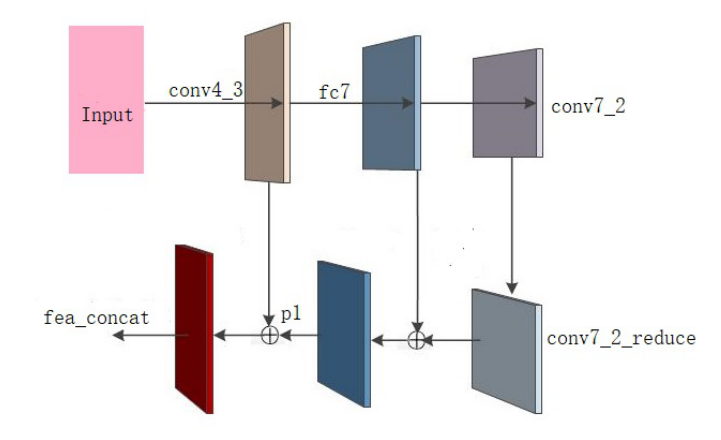
Figure 5. Reverse feature propagation.